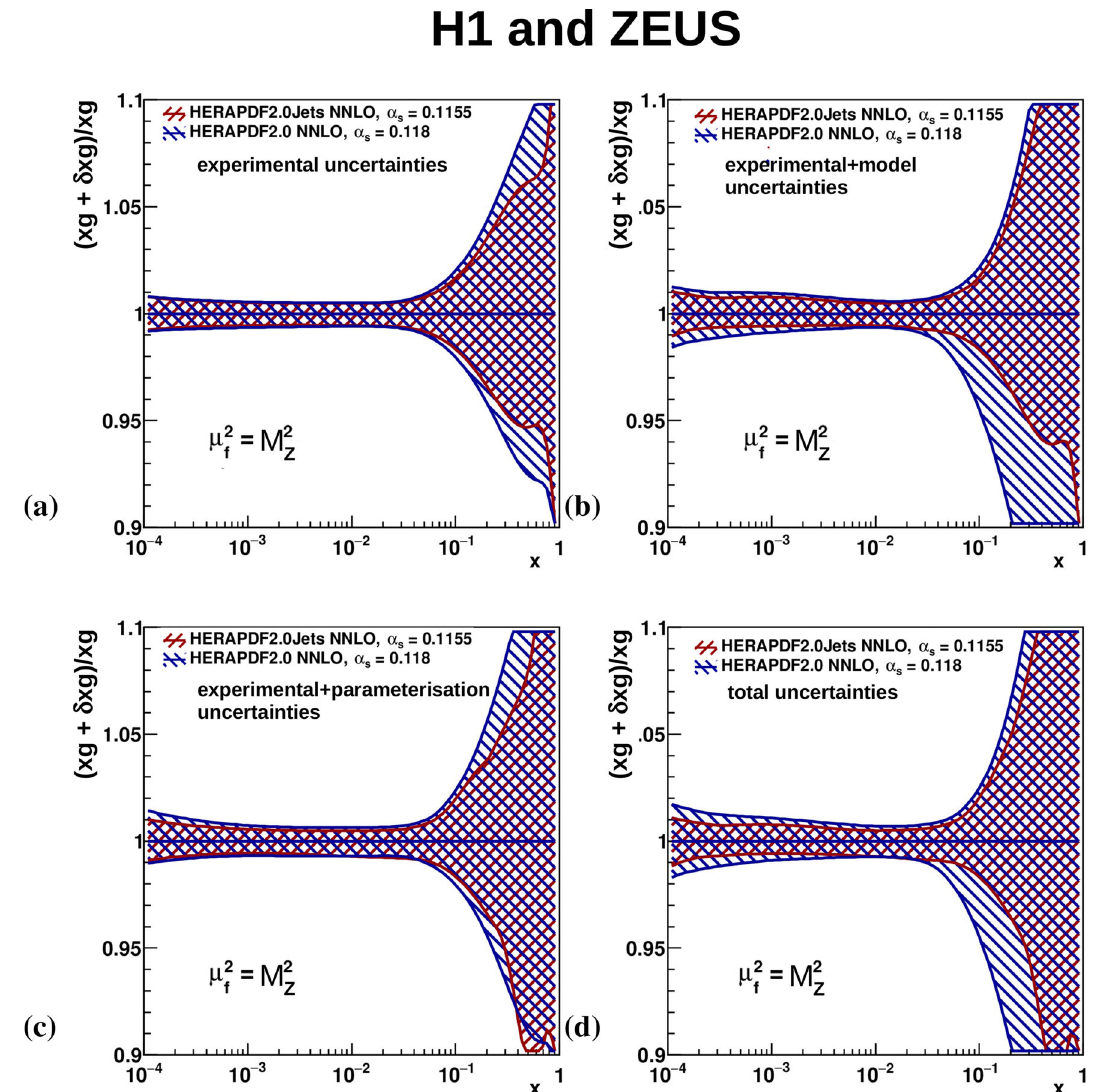
Fig. 11 ComparisonofthenormaliseduncertaintiesonthegluonPDFs mental, i.e. fit, b experimental plus model, c) experimental plus param- ) = 0 . 1155 and HERAPDF2.0 of HERAPDF2.0Jets NNLO for α s ( M 2 eterisation, d total uncertainties. The uncertainties on both gluon PDFs Z ) = 0 . 118, both at the scale μ 2 = M 2 are shown as differently hatched NNLO for α s ( M 2 , for a experi- Z Z f